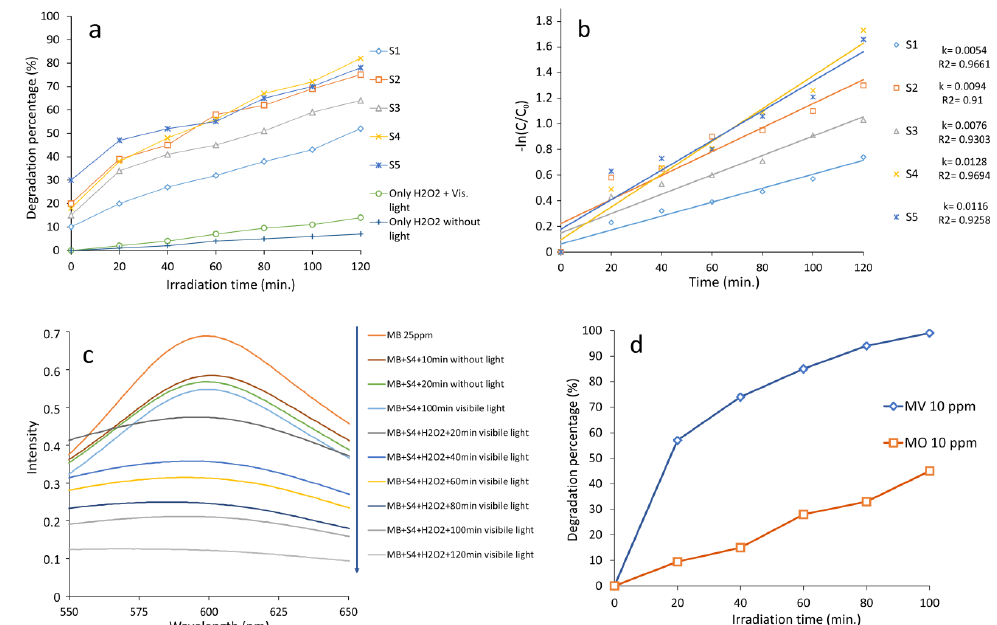
Figure 6. ( a ) Photocatalytic degradation of MB (1–5 samples) under visible light assisted by H 2 O 2 . ( b ) Pseudo-first-order kinetics of MB degradation by samples 1–5. ( c ) Temporal changes in